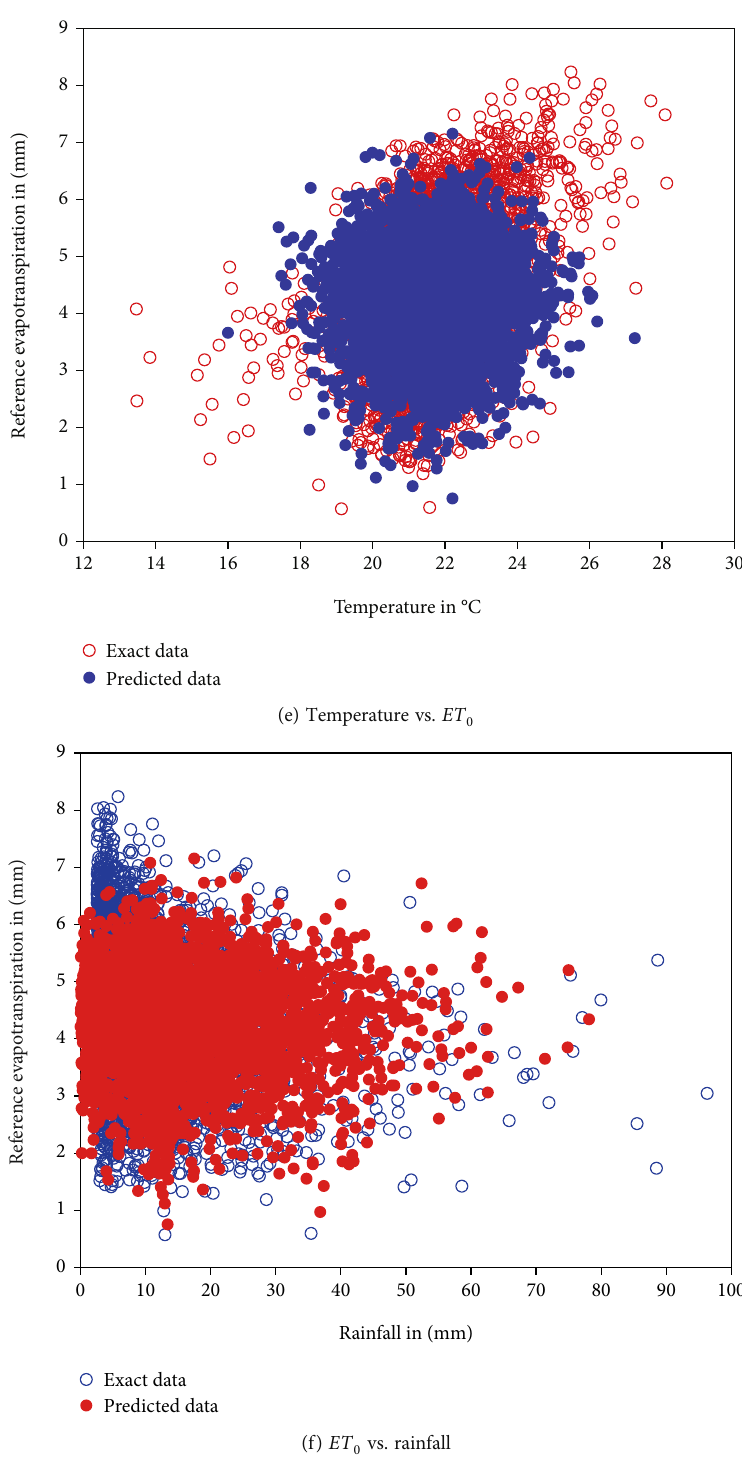
Figure 13: Predictions from stochastic